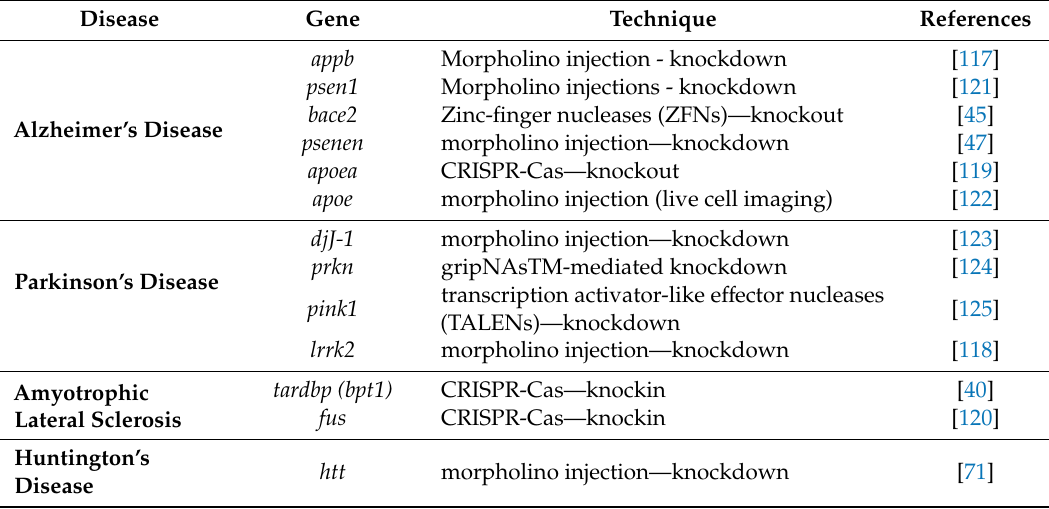
Table 3. Transgenic zebrafish models for neurodegenerative